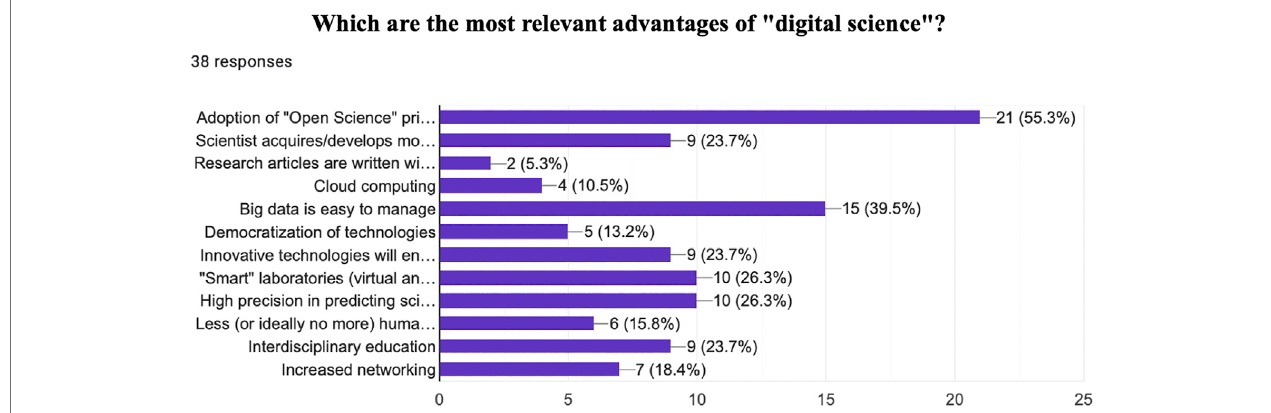
FIGURE 3 | Bar chart. Which are the most relevant advantages of “ digital science ” ? Option were: adoption of “ Open Science ” principles, scientist acquires/ develops more digital and technological skills, research articles are written with AI technologies, cloud computing, big data is easy to manage, democratization of technologies, innovative technologies will enable advanced data analysis, “ Smart ” laboratories (virtual and cloud-based labs, co-working facilities, DIY spaces, real-time collaborations), high precision in predicting scienti fi c results using technologies, less (or ideally no more) human/animal experiments due to high precision simulations with AI, interdisciplinary education, increased networking. Responders selected “ Adoption of ‘ Open Science ’ principles ” (55.3%), “‘ Smart ’ laboratories (virtual and cloud-based labs, co-working facilities, DIY spaces, real-time collaborations) ” (26.3%), “ High precision in predicting scienti fi c results using technologies ” (26.3%) and “ Big data is easy to manage ” (39.5%), as the most relevant advantages of digital